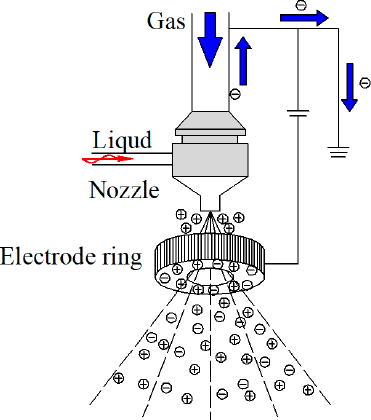
Figure 4. The water mist droplet size at di ff erent distances and charged voltages.